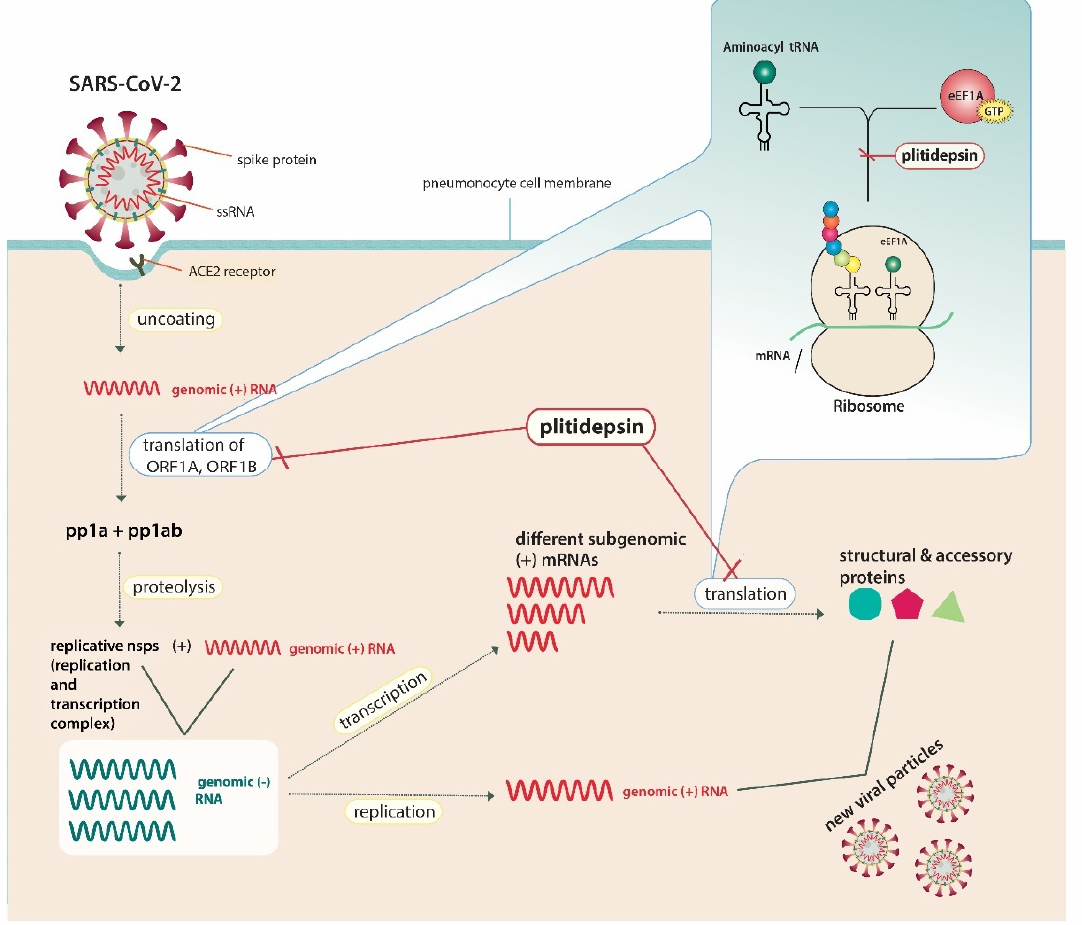
Figure 1. Plitidepsin’s host-directed anti-SARS-CoV-2 action mechanisms.SARS-CoV-2 possesses a single-stranded RNA (ssRNA) genome. The angiotensin converting enzyme-2 (ACE2) receptor is identified as the cell-surface receptor of SARS-CoV-2. Specific spike protein interactions with ACE2 receptors promote viral fusion with the cellular